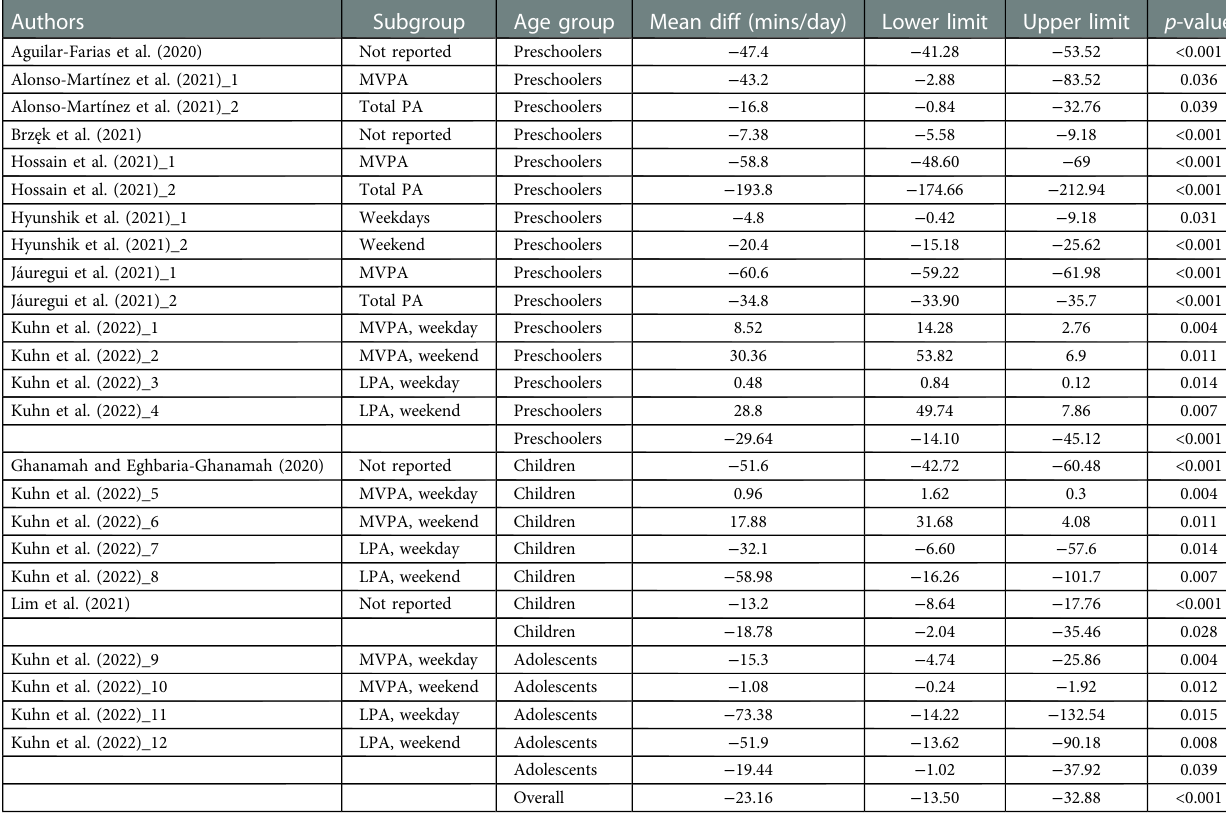
TABLE 3A Outcomes: the mean time change in PA before and during COVID-19.